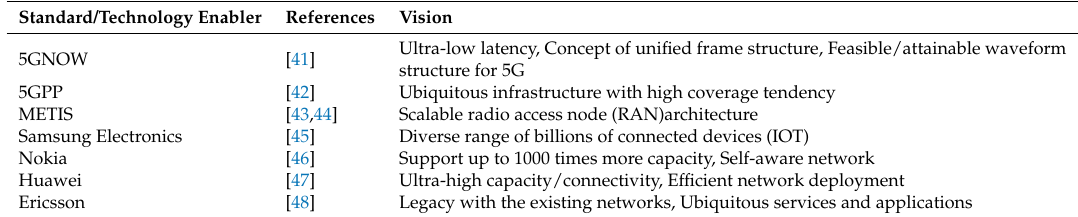
Table 2. Standards and technology enablers for